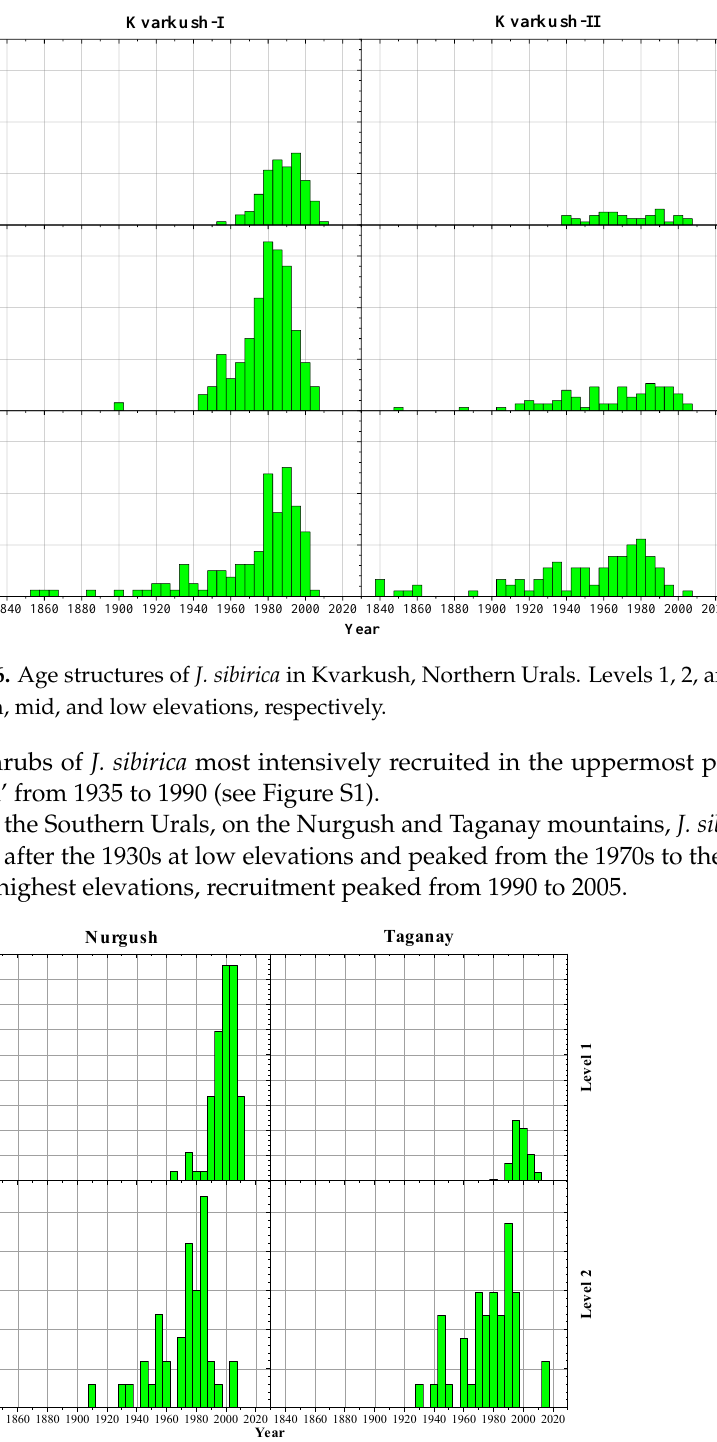
Figure 5. Age structures of J. sibirica at three altitudinal levels in Zyryanovka, Northern Urals. Levels 1, 2, and 3 correspond to the high, mid, and low elevations, respectively.